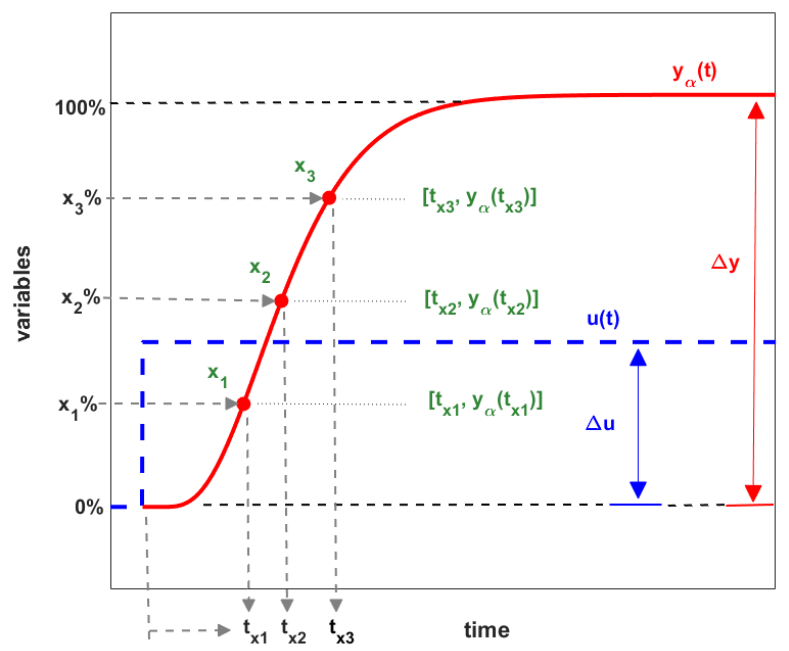
Figure 6. Step-input signal u(t), process reaction curve y α (t), and arbitrary representative points {x 1 , x 2 , and x 3 } on the process reaction curve. { ∆ y, ∆ u, t x1 , t x2 , t x3 } are the parameters taken from the process reaction curve required for the identification.